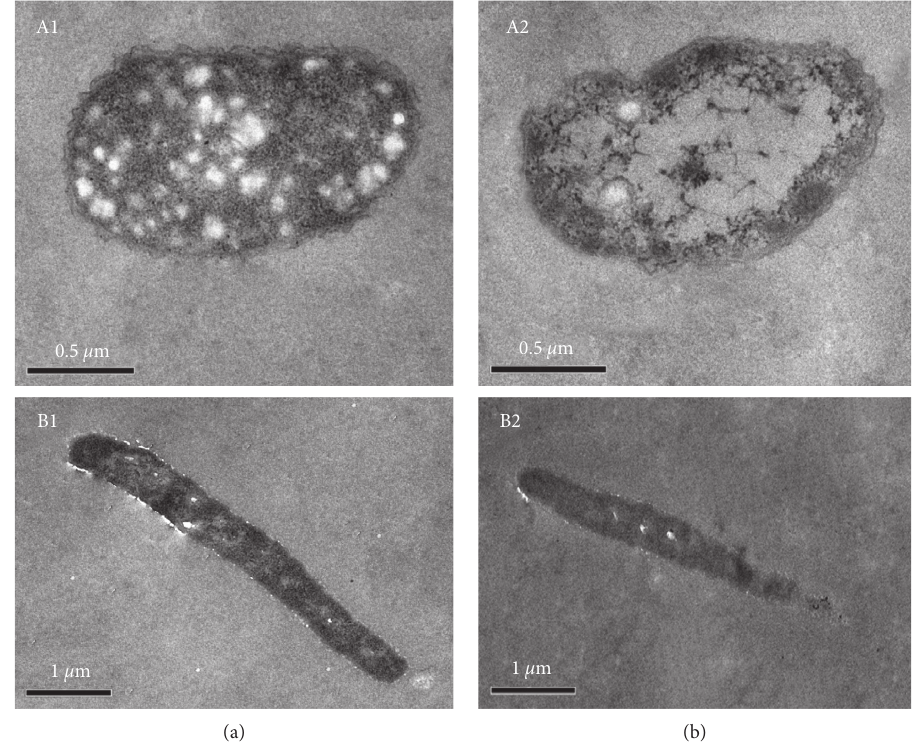
Figure 6: Transmission electron micrographs of P. fluorescens (a) and S. putrefaciens (b) (A1–B1, control; A2–B2, addition of 4 × MIC